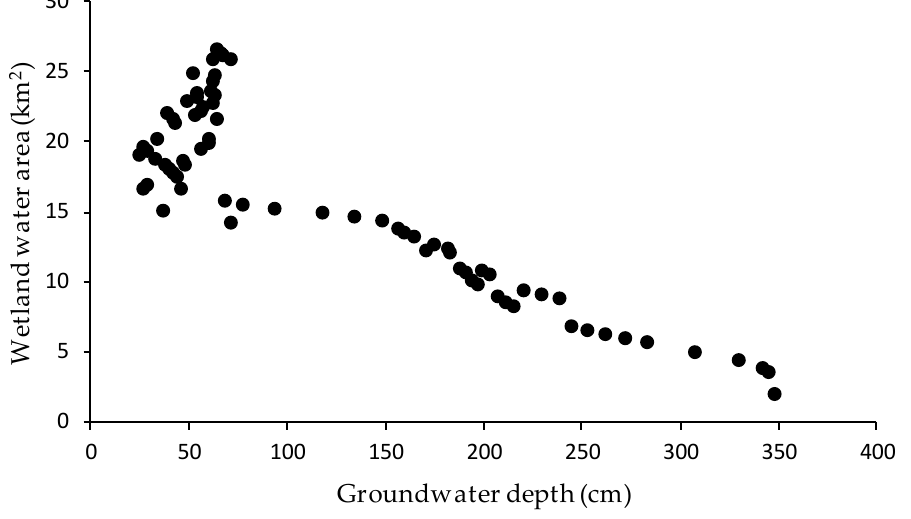
Figure 4. Correlation between wetland water area and groundwater depth.